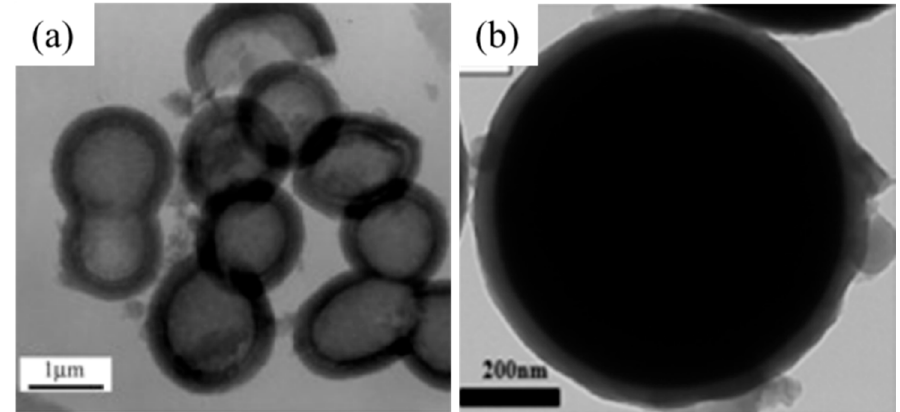
Figure 8. TEM images of ( a ) hollow poly( O -anisidine) (POA), reprinted with permission from [81]. Copyright IOP Publishing, 2011 and ( b ) POA/silica core/shell structure, reprinted with permission from [82]. Copyright IOP Publishing, 2017.